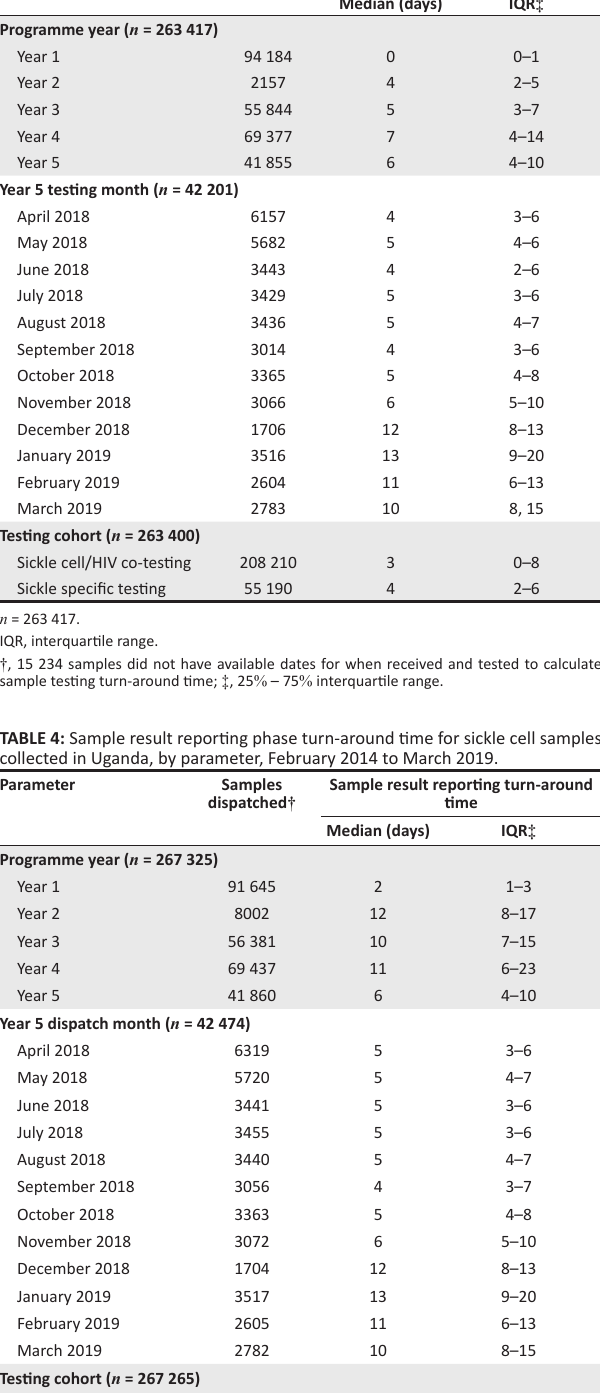
TABLE 3: Sample testing phase turn-around time for sickle cell samples collected in Uganda, by parameter, February 2014 to March 2019. Parameter Samples tested † Sample testing turn-around time Median